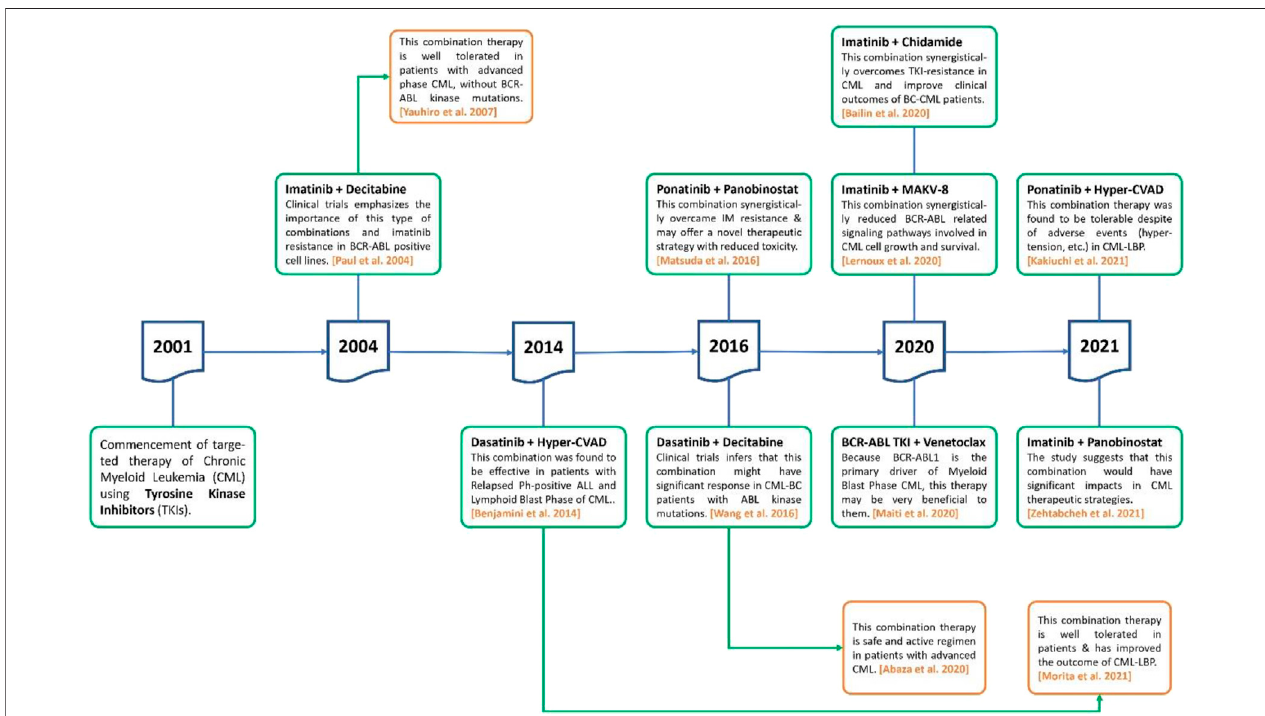
FIGURE 2 | The role of TKIs in combination with epigenetic drugs to treat CML during last 2 decades.